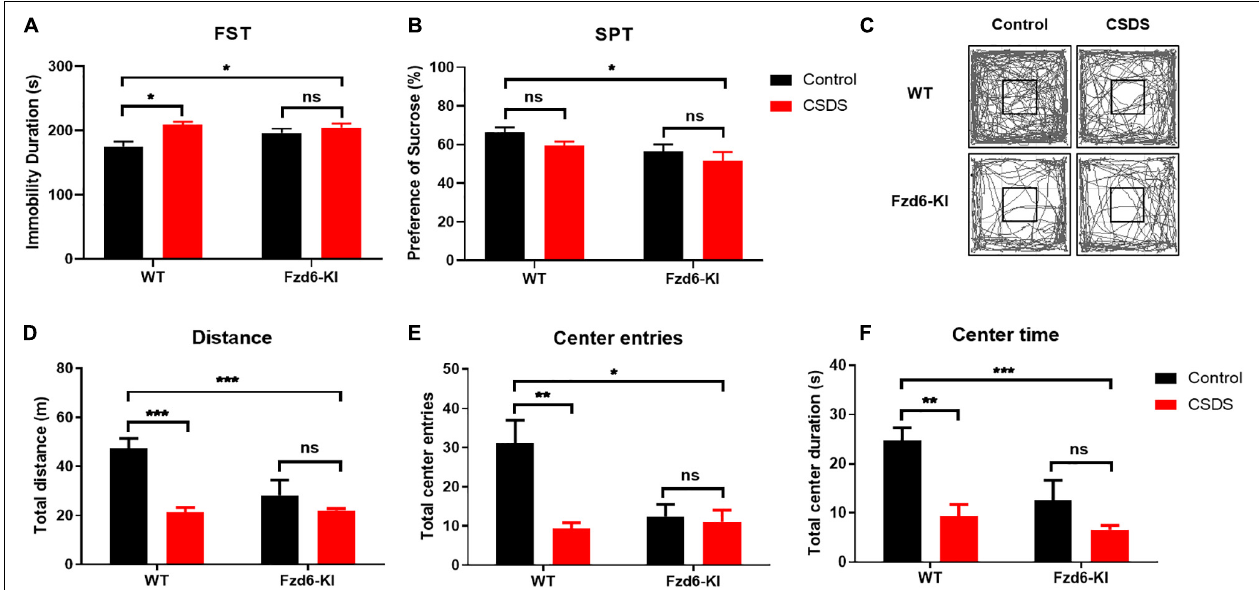
FIGURE 4 | Changes of depressive- and anxiety-like behaviors in Fzd6 -KI mice after CSDS. (A,B) Depressive-like behaviors. Graphs show immobility time, scored in seconds, in panel (A) forced swimming test (FST) and percentage of sucrose consumption over total fluid consumption in panel (B) sucrose preference test (SPT). (C–F) Anxiety-like behaviors. (C) Representative tracking plot of open field test (OFT). Graphs present (D) total distance traveled, (E) center entries, and (F) time spent in center area. Animals were tested in 3–5 mice/group. Data were analyzed using two-way ANOVA, and all data are presented as mean ± SEM. * p < 0.05, ** p < 0.01, *** p < 0.001, ns, not